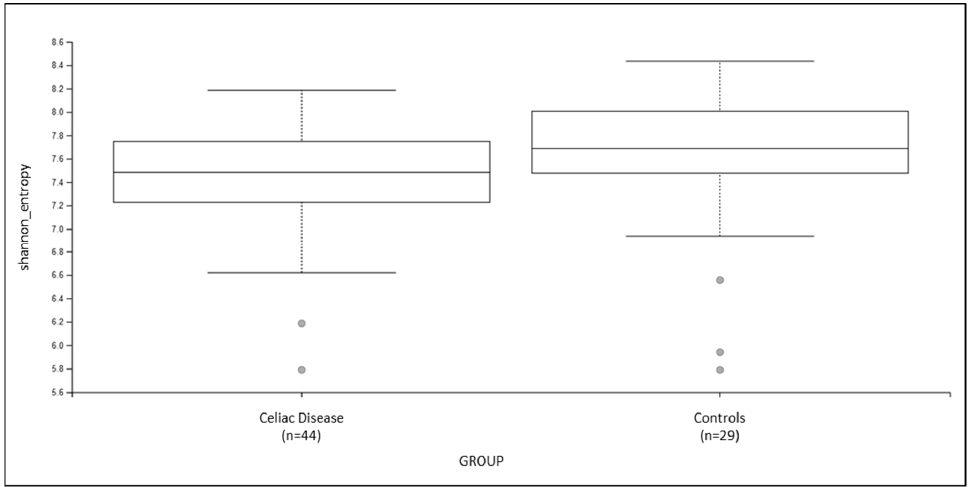
Figure 1 . Boxplot for group-specific Shannon’s entropy distributions. See Table 2 and